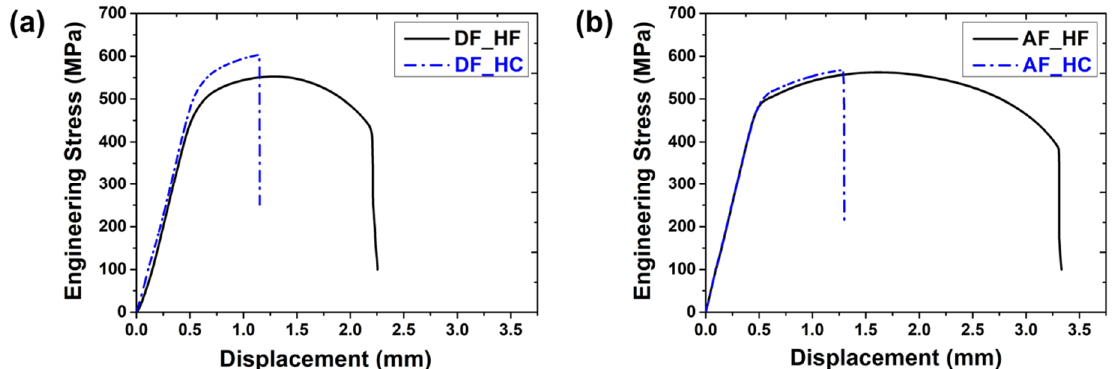
Figure 4. Engineering stress–displacement curves of the WJs with the ( a ) DF and ( b ) AF, as obtained after the slow strain rate testing (SSRT) in the hydrogen-free (HF) and hydrogen-charged (HC) environments.